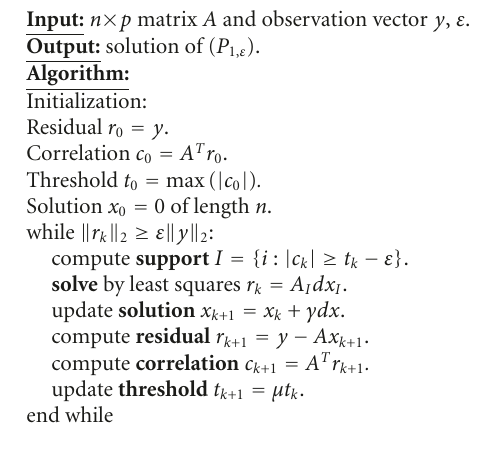
Algorithm 2: Iterative thresholding by least squares